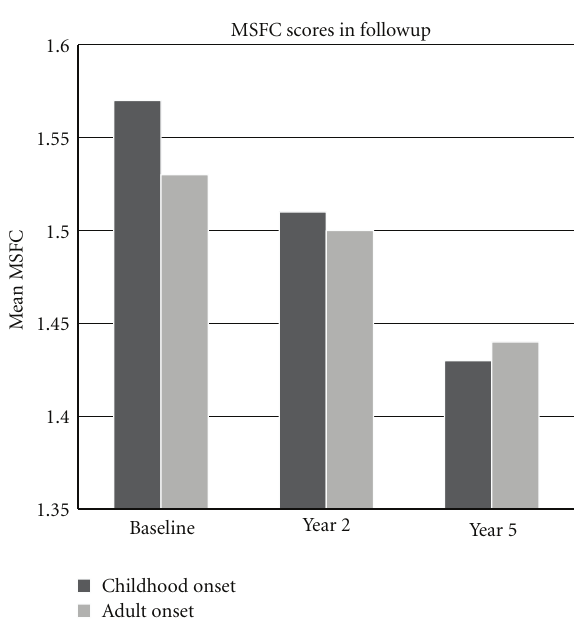
Figure 1: MSFC in the follow-up period (MSFC at baseline versus the 5th year, P = 0 . 02).